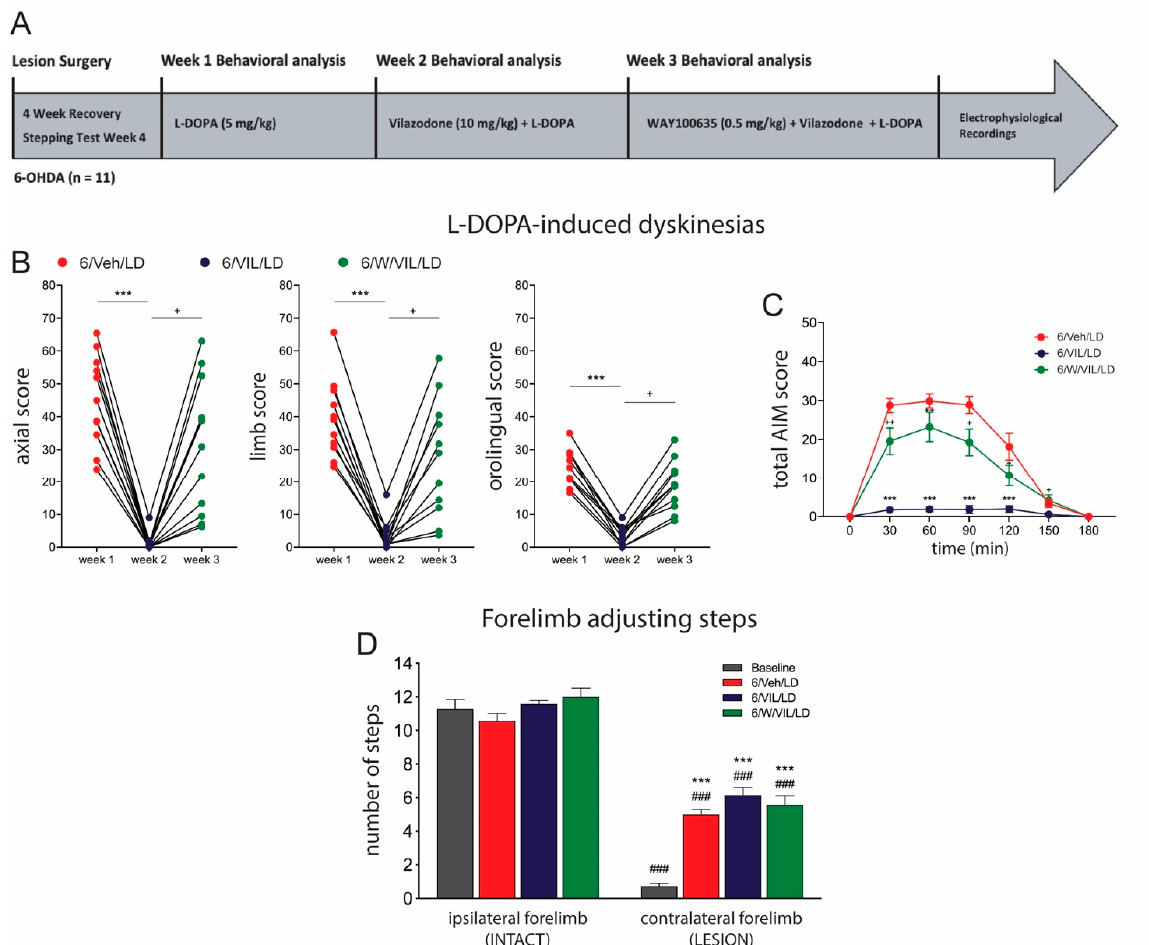
Figure 3. The 5-HTr 1A antagonist WAY-100635 (WAY) blocks the antidyskinetic effects of vilazodone. ( A ) Experimental design/timeline of study. ( B , C ) AIMs in 6-OHDA-lesioned rats treated with vehicle + L-DOPA (5 mg/kg, i.p.) (6/Veh/LD) in week 1, vilazodone (10 mg/kg, i.p.) + L-DOPA (6/VIL/LD) in week 2 and WAY-100635 (0.5 mg/kg, i.p.) + vilazodone + L-DOPA (6/W/VIL/LD) in week 3. The video analysis revealed that vilazodone co-administration (week 2) significantly attenuated the expression of AIMs compared to L-DOPA-only treatment (week 1), whereas WAY co-administration (week 3) significantly inhibited this beneficial effect of vilazodone treatment. This was shown for axial, limb and orolingual AIMs (individual animals) ( B ) and for total AIM scores (mean ± SEM) across 180 min after L-DOPA administration ( C ). *** p < 0.001, 6/VIL/LD vs. 6/Veh/LD; + p < 0.05, ++ p < 0.01, 6/W/VIL/LD vs. 6/VIL/LD. ( D ) Forelimb stepping scores (mean ± SEM) after these drug treatments. Neither vilazodone (6/VIL/LD) nor WAY (6/W/VIL/LD) had any effects on the L-DOPA-induced motor improvements (6/Veh/LD vs. baseline), as assessed by the forelimb stepping test. ### p < 0.001, vs. ipsilateral (INTACT) side; *** p < 0.001, vs. contralateral (LESION)